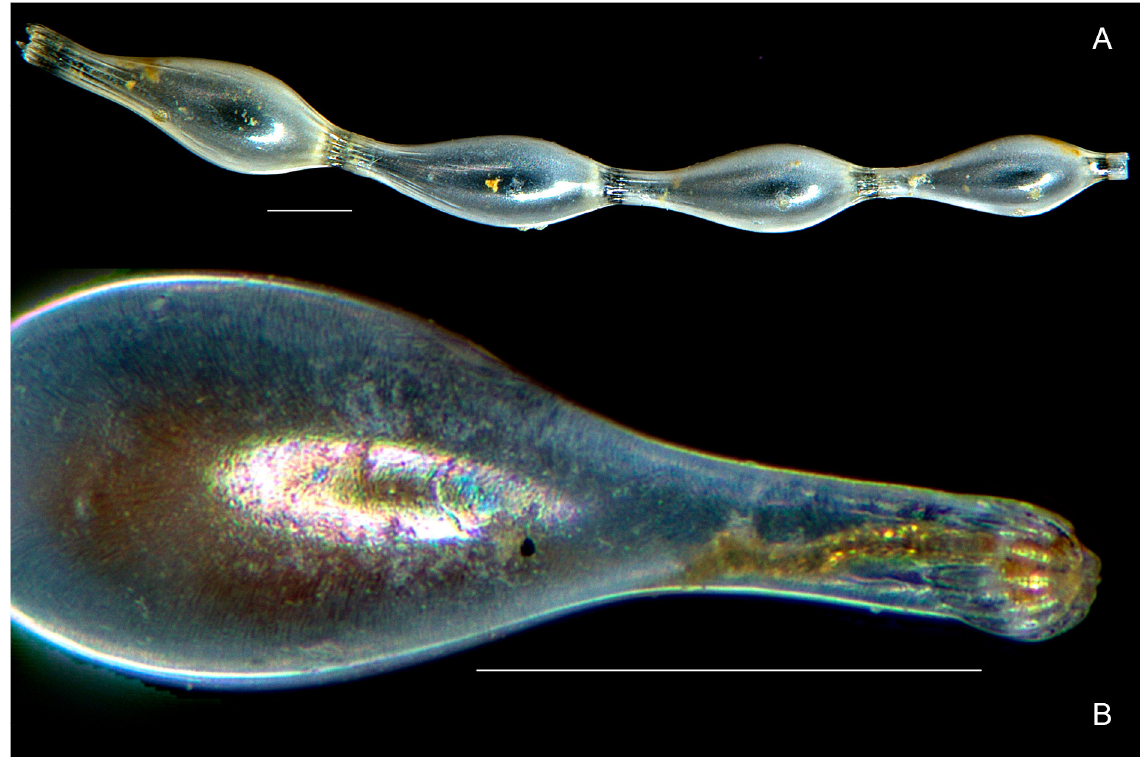
Fig. 9. Grigelis semirugosus ? (d’Orbigny, 1846). A . Specimen with missing initial end (BIOICE 3669, IINH 40403). B . Detail of aperture (BIOICE 2465, IINH 40402). Light source combination of incident light and dark field. Scale bars = 0.25